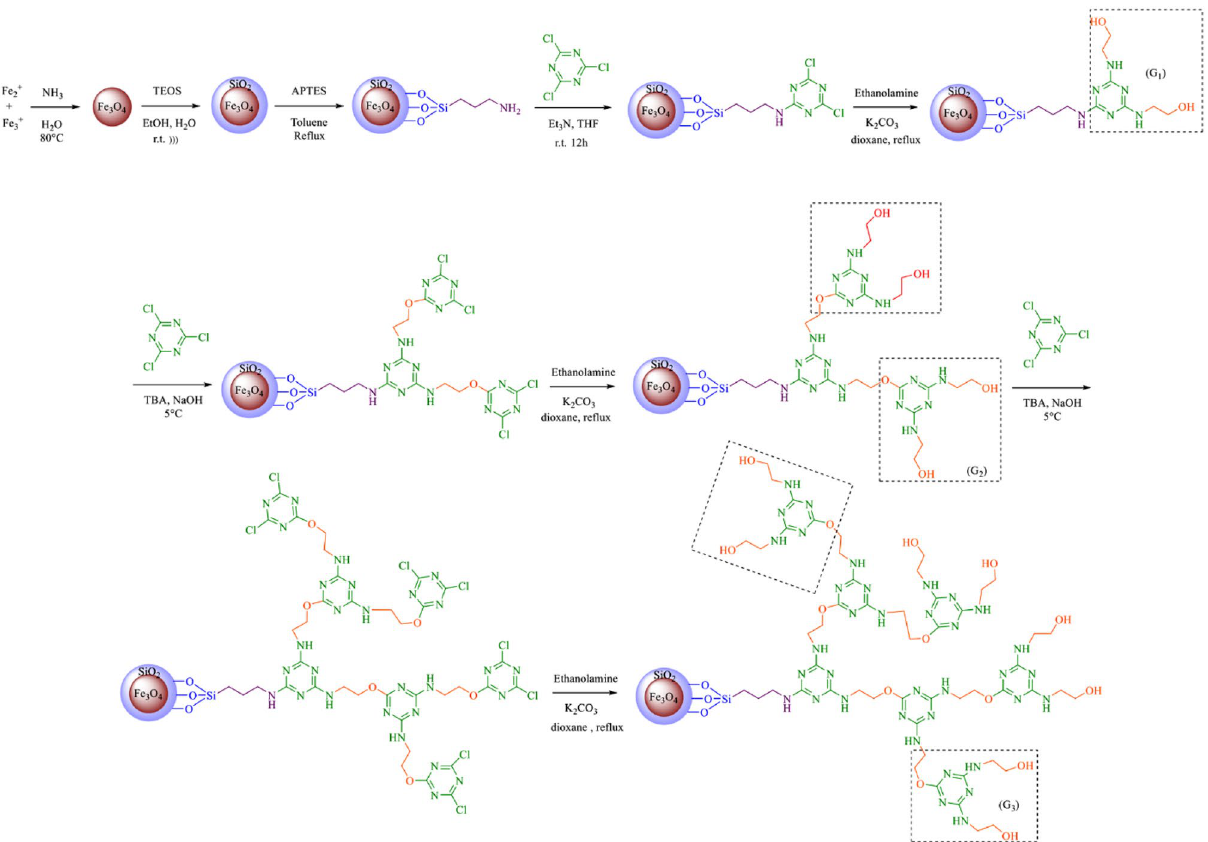
Figure 1. Synthetic pathway for construction of dendrimer-coated magnetite nanoparticles (Fe 3 O 4 @SiO 2 @